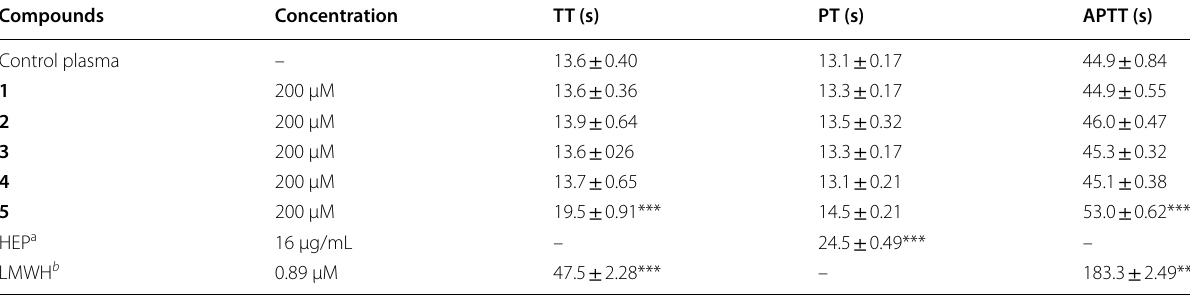
*** p < 0.001; n = 3 a Positive control of PT; b Positive control of APTT and TT